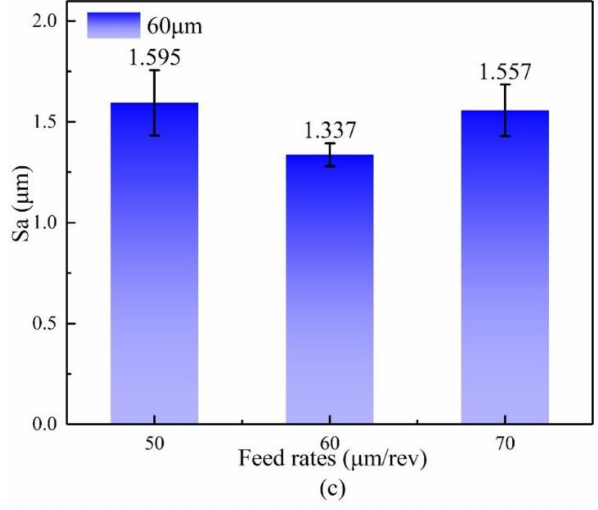
Figure 4. The roughness of machined surface at different feed rates. ( a ) Grain size = 30 µ m, ( b ) Grain size = 40 µ m, ( c ) Grain size = 60 µ